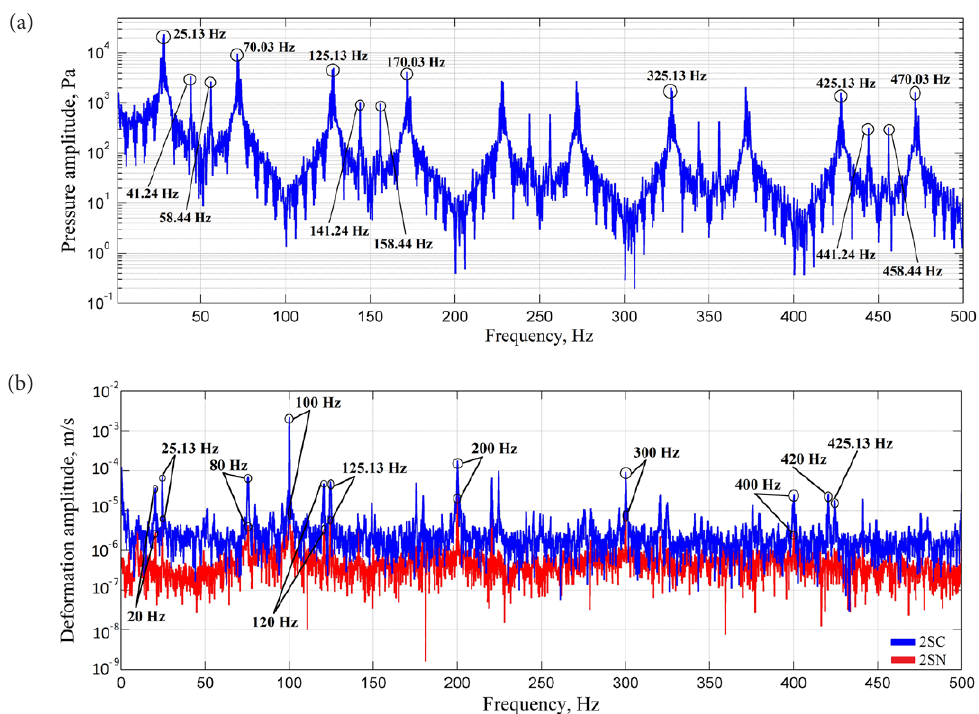
Figure 7. Graphs of spectrum analyses (in logarithm form): (a) – frequency’s response of fluid pressure inside high-pressure hoses; (b) – frequency’s response of high-pressure